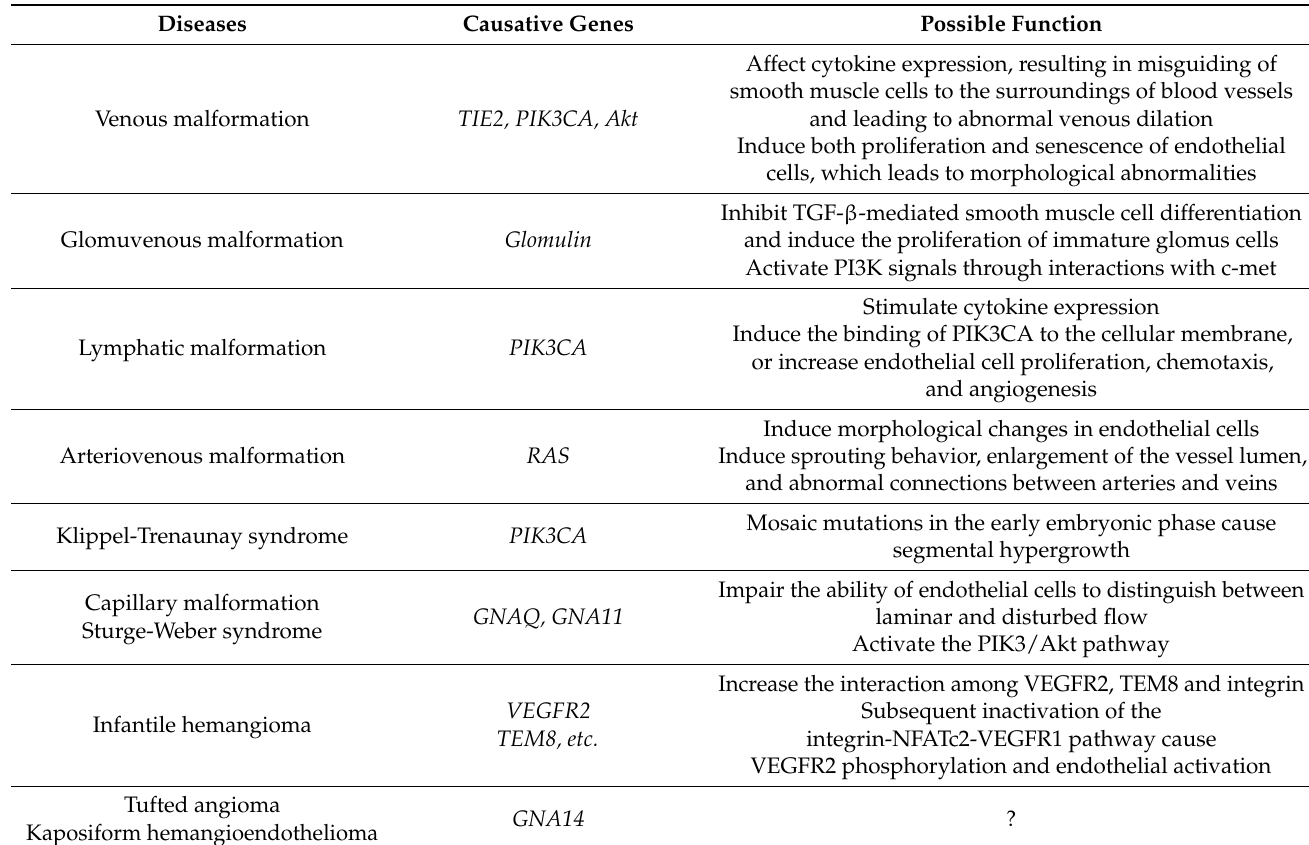
Table 3. Molecular aspect of vascular